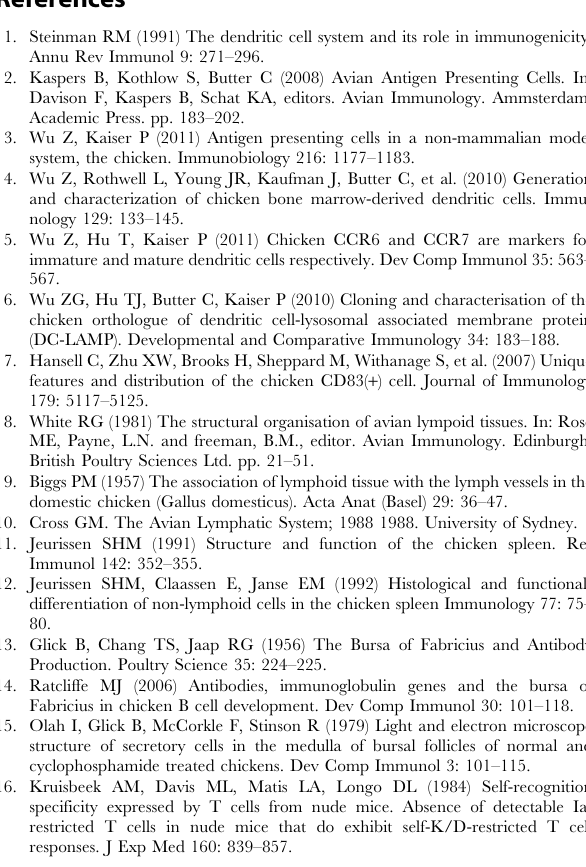
Figure S2 Sequencing primers used to determine sequences of the 5 9 end of the chicken DEC205 gene from BAC DNA. The primer sequences are provided in table S2. Figure S3 Structure of chicken DEC205-human IgG-Fc fusion. Figure S4 Structure of the CD83-human IgG1-Fc fusion protein.